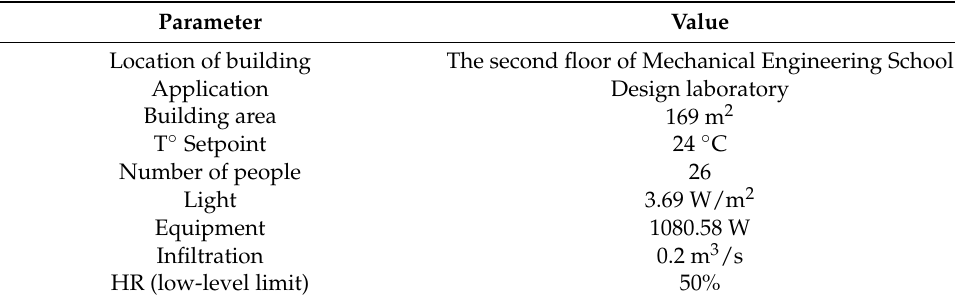
Table 1. Space parameters for cooling load